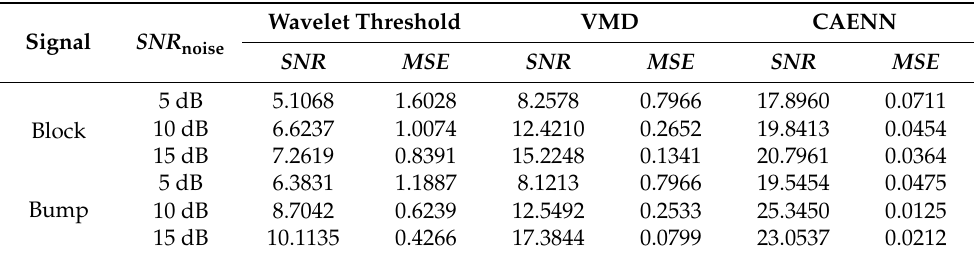
Table 5. The SNR and MSE after noise reduction by three methods when superimposed with noise with different SNR s.